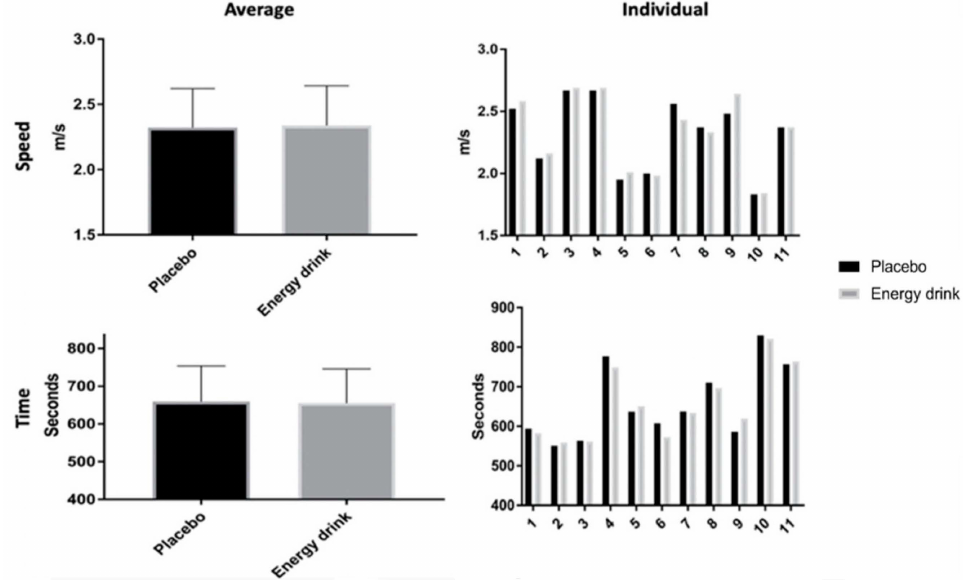
Figure 2. Running performance time and speed. Note. m/s: meter per